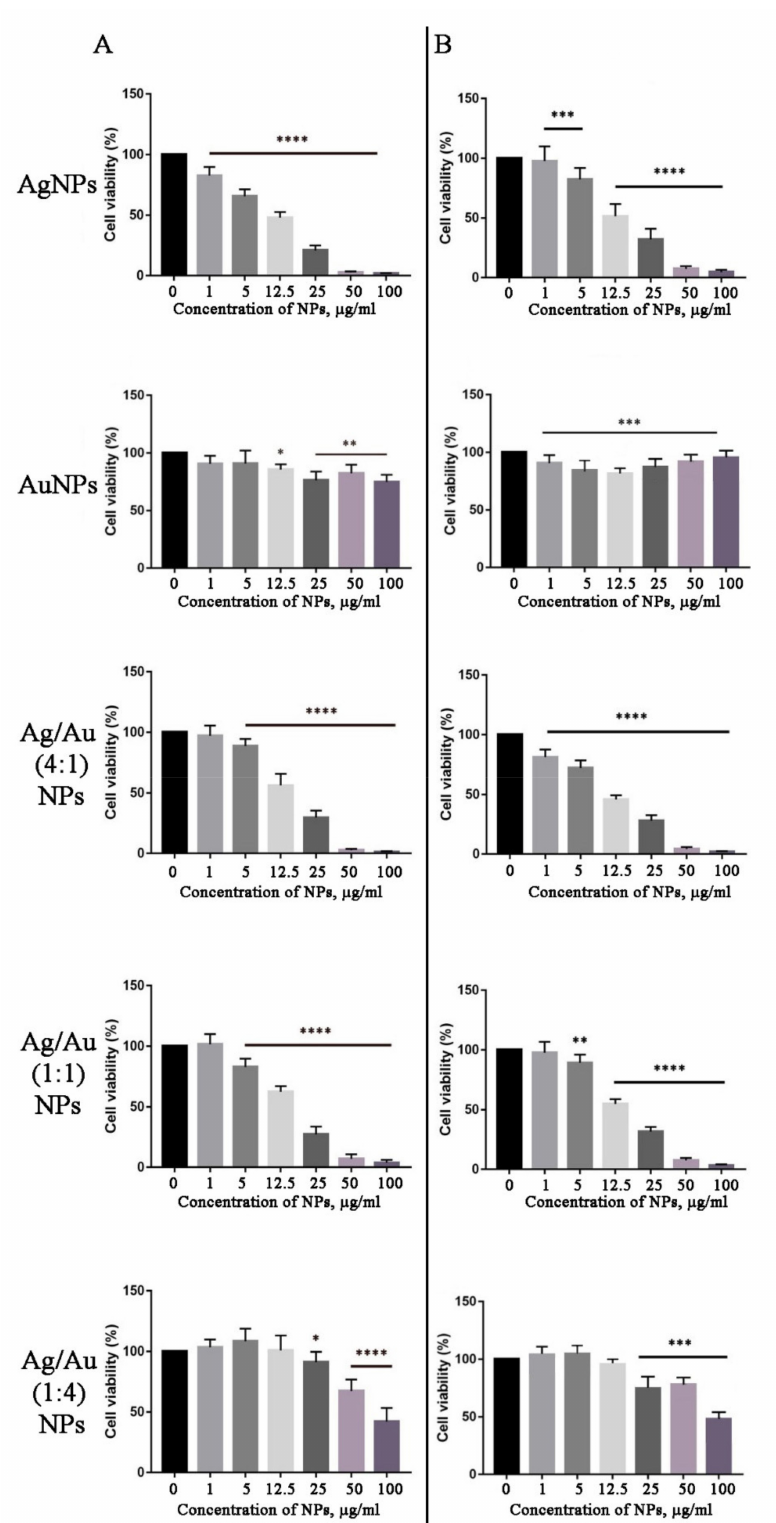
Figure 12. Cell viability of N2A mouse neuroblastoma cells ( A ) and the NIH 3T3 embryonic fibroblast cell line ( B ) in response to AgNPs, AuNPs, and bimetallic Ag/Au NPs synthesized with L . erythrorhi- zon callus extract, evaluated by MTT assay. Data are presented as the mean ± SE, * p < 0.05, ** p < 0.01, *** p < 0.001, **** p <